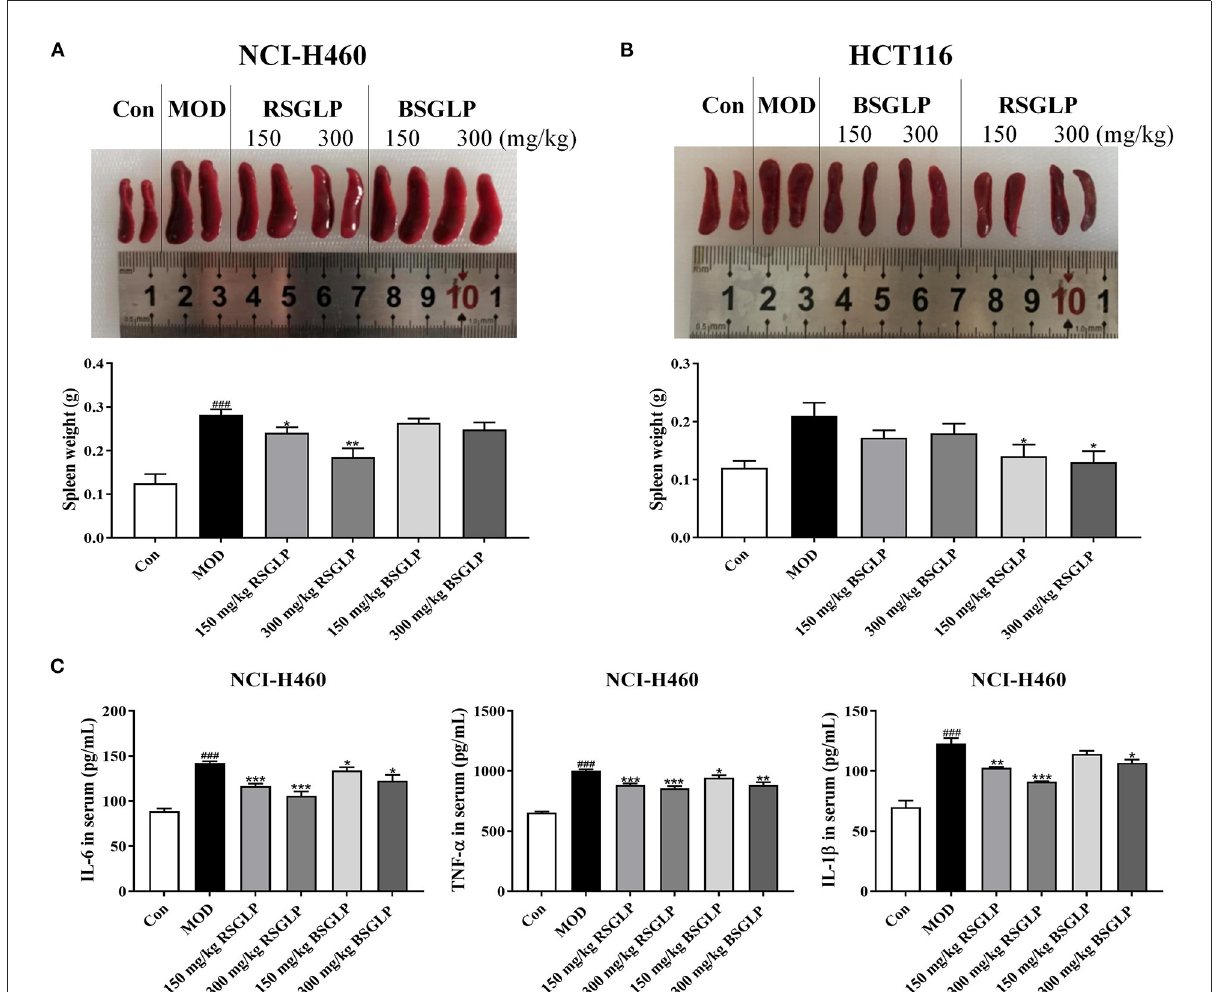
FIGURE7 Comparison of the inhibitory effects of RSGLP and BSGLP on splenomegaly and inflammation in xenograft nude mice. Image of the spleen samples and spleen weight of the NCI-H460 (A) and HCT116 (B) xenograft nude mice. (C) Serum levels of inflammatory cytokines IL-6, IL-1 β , and TNF- α in the NCI-H460 xenograft nude mice. All values are presented as the mean ± SE ( n = 7–8). * p < 0.05, ** p < 0.01, *** p < 0.001, compared with MOD group. ### p < 0.001, compared with Con